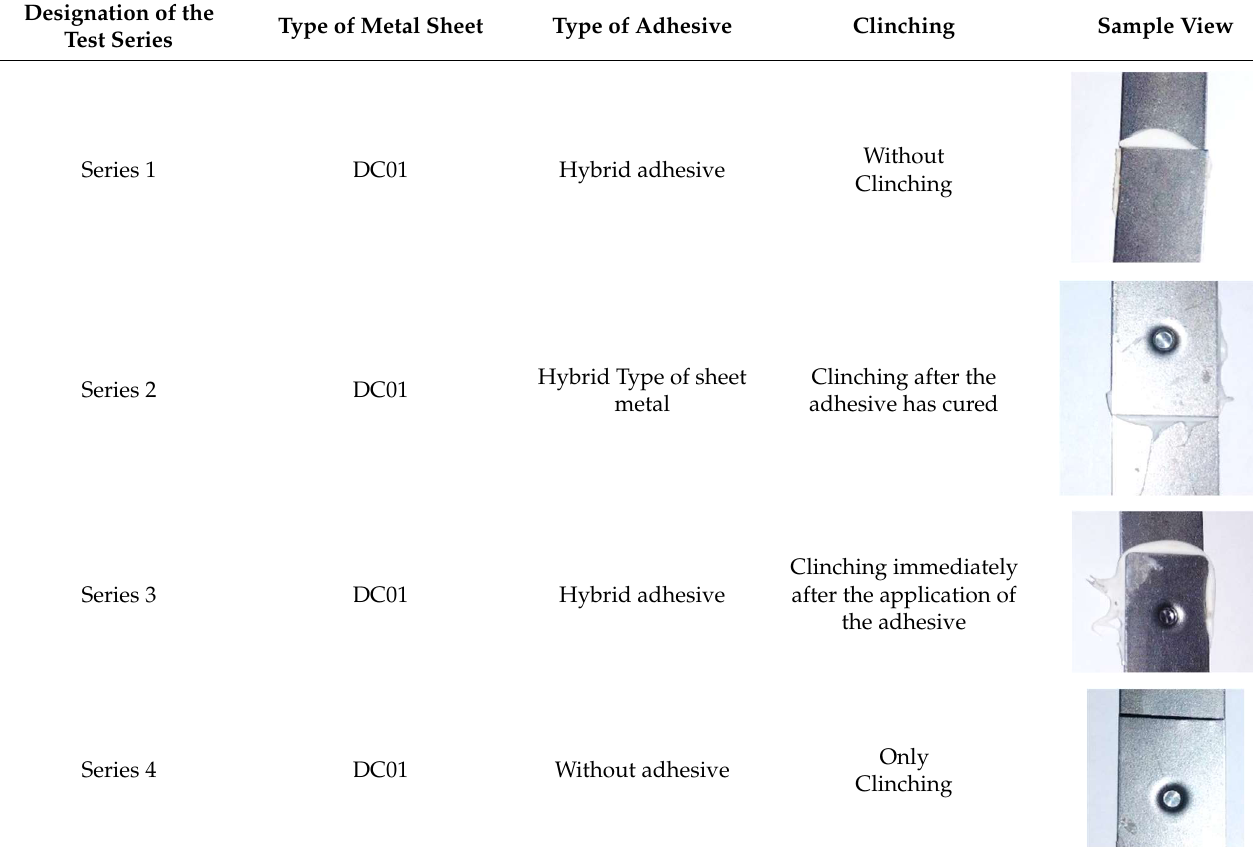
Figure 7. Plot of the dependence of the splicing force as a function of the punch path. Table 2. Summary of research series.